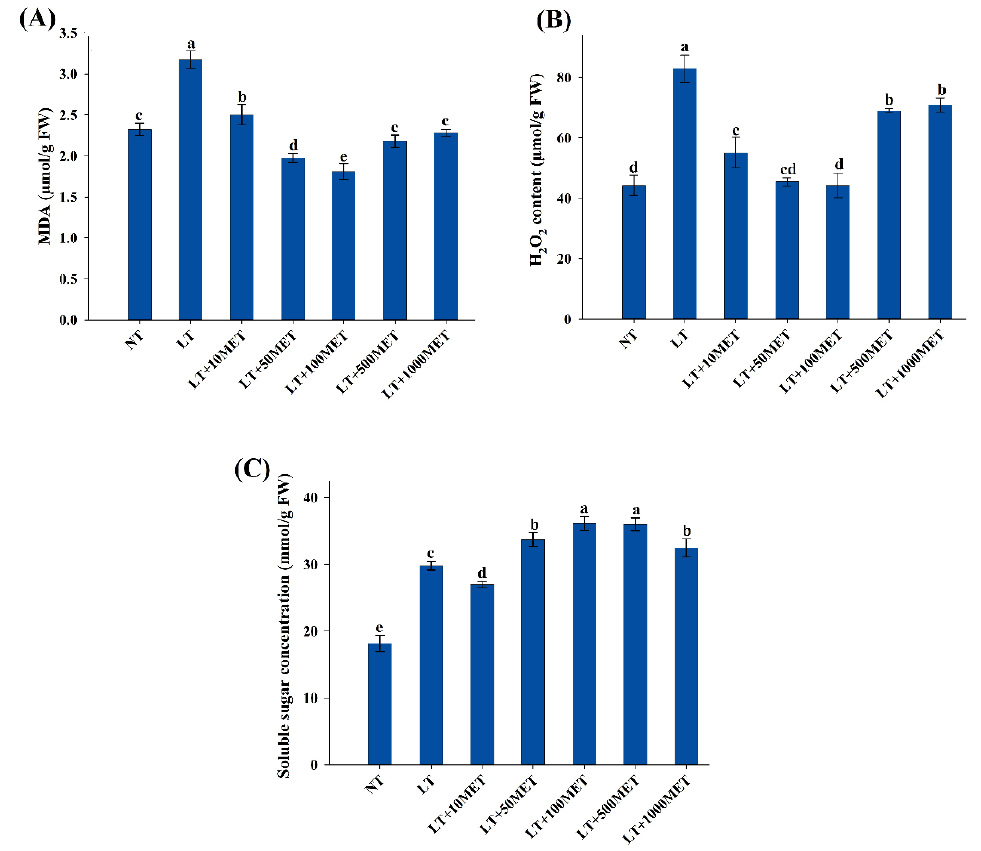
Figure 2. Effects of exogenous melatonin on MDA ( A ), H 2 O 2 ( B ), and soluble sugar concentrations ( C ) in strawberry seedlings under cold stress. Plants treated with distilled water under the normal conditions (25 °C) served as control (NT). The strawberry seedlings were pretreated with distilled water (LT), 10 µ M melatonin (LT + 10MET), 50 µ M melatonin (LT + 50MET), 100 µ M melatonin (LT + 100MET), 500 µ M melatonin (LT + 500MET), and 1000 µ M melatonin (LT + 1000MET) 3 times in a two-day interval and then exposed to cold stress for 2 days. Graphs represent the mean of three biological replicates. Values labeled with different letters indicate significant differences among treatments at ( p ≤ 0.05) by LSD.